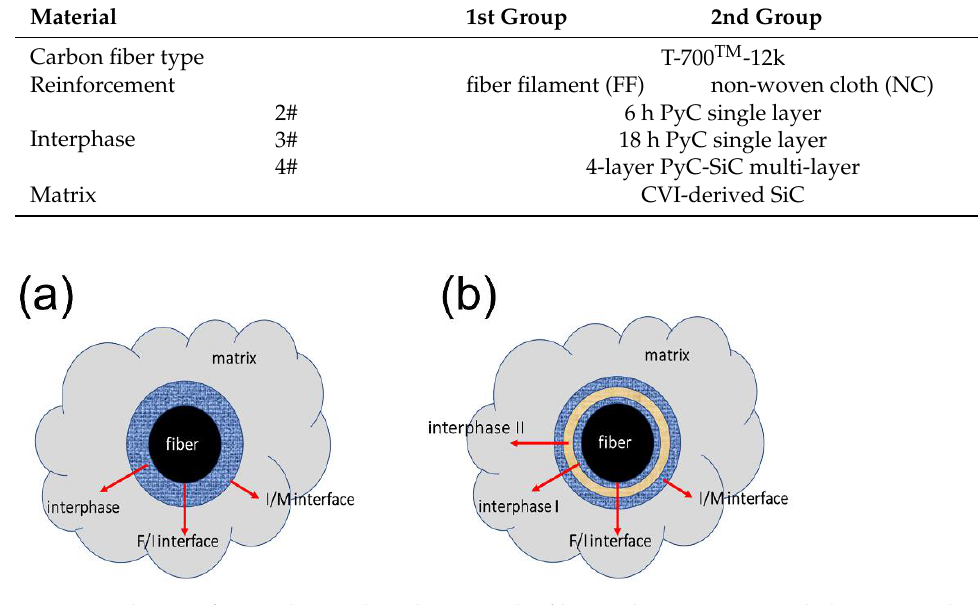
Figure 1. The interface and interphase between the fiber and matrix: ( a ) single-layer interphase; ( b ) multi-layer interphase. (F—fiber, M—matrix, and I—interphase). Table 1. Overall information regarding all of the